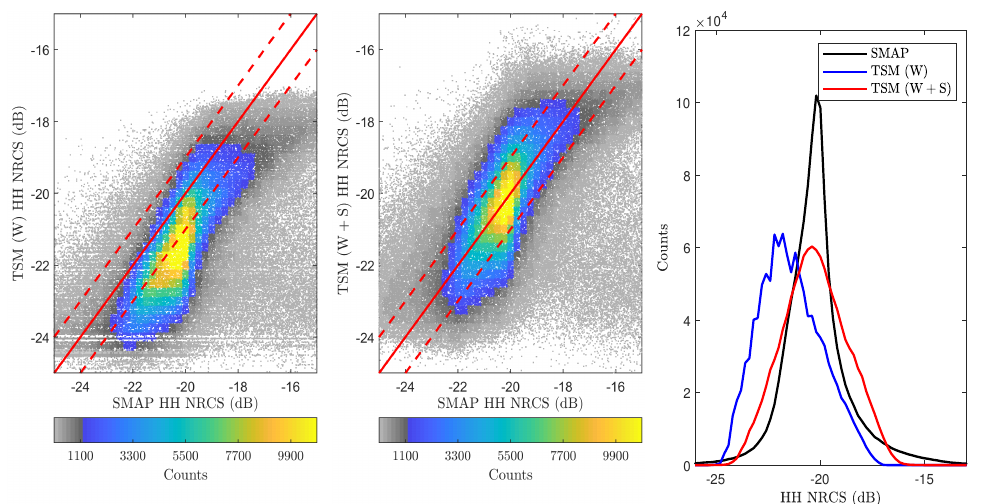
Figure 15. HH-polarized backscatter NRCS model predictions for all L1-C data at glo_30m resolution. Plots from ( left ) to ( right ): SMAP vs. wind-only, SMAP vs. wind and swell, and distributions of NRCS data.